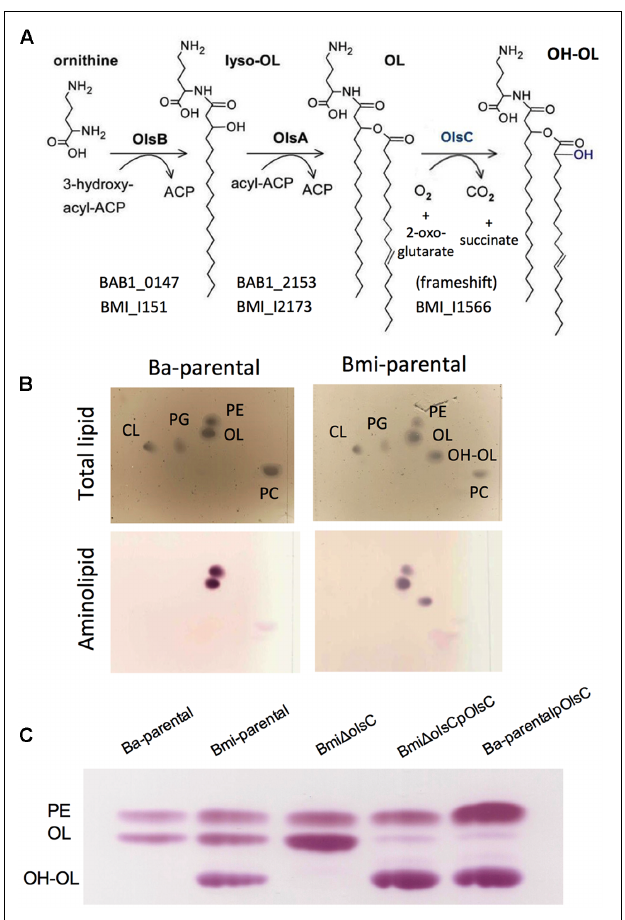
FIGURE 3 | The Brucella lpxO orthologs encode an acyl hydroxylase acting on ornithine lipids. (A) Pathway of synthesis of ornithine lipids in α -2 Proteobacteria (adapted from Geiger et al., 2010); the ORFs of B. abortus and B. microti are indicated, whereas B. microti , B. vulpis , and O. anthropi contain an intact olsC acyl hydroxylase gene, B. abortus and other Brucella spp. carry a frame-shift in the olsC homolog. (B) Lipid profile of B. abortus wild-type